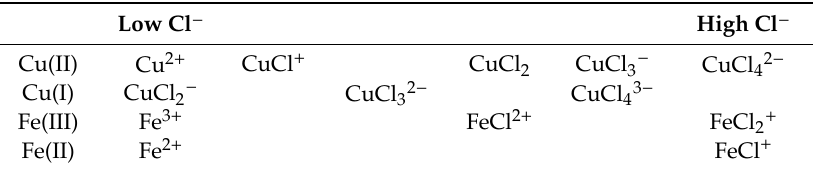
Table 1. Ion distribution as a function of the chloride concentration [36–38].